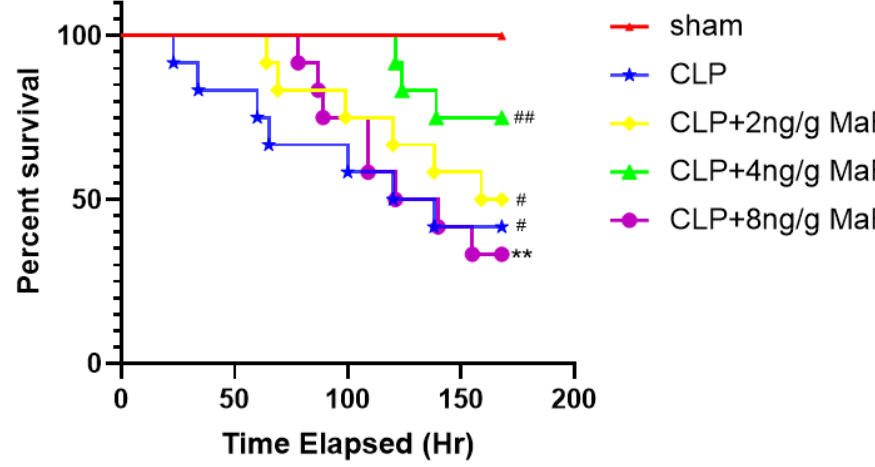
Figure 1. Effects of MaR1 treatment under different doses on mortality in septic rats. The median time CLP group is 129. The median time CLP+2 ng/g of the MaR1group is 163.5. The median time CLP+8 ng/g of the MaR1group is 130.4. The number of deaths in the sham group is 0. The number of deaths in the CLP group is 7. The number of deaths in the CLP+2ng/g of the MaR1 group is 6. The number of deaths in the CLP+4ng/g of the MaR1 group is 3. The number of deaths in the CLP+2ng/g of MaR1 group is 8; ** p < 0.01, compared to the Sham group; # p < 0.05, ## p < 0.01, compared to the CLP group ( n = 12).